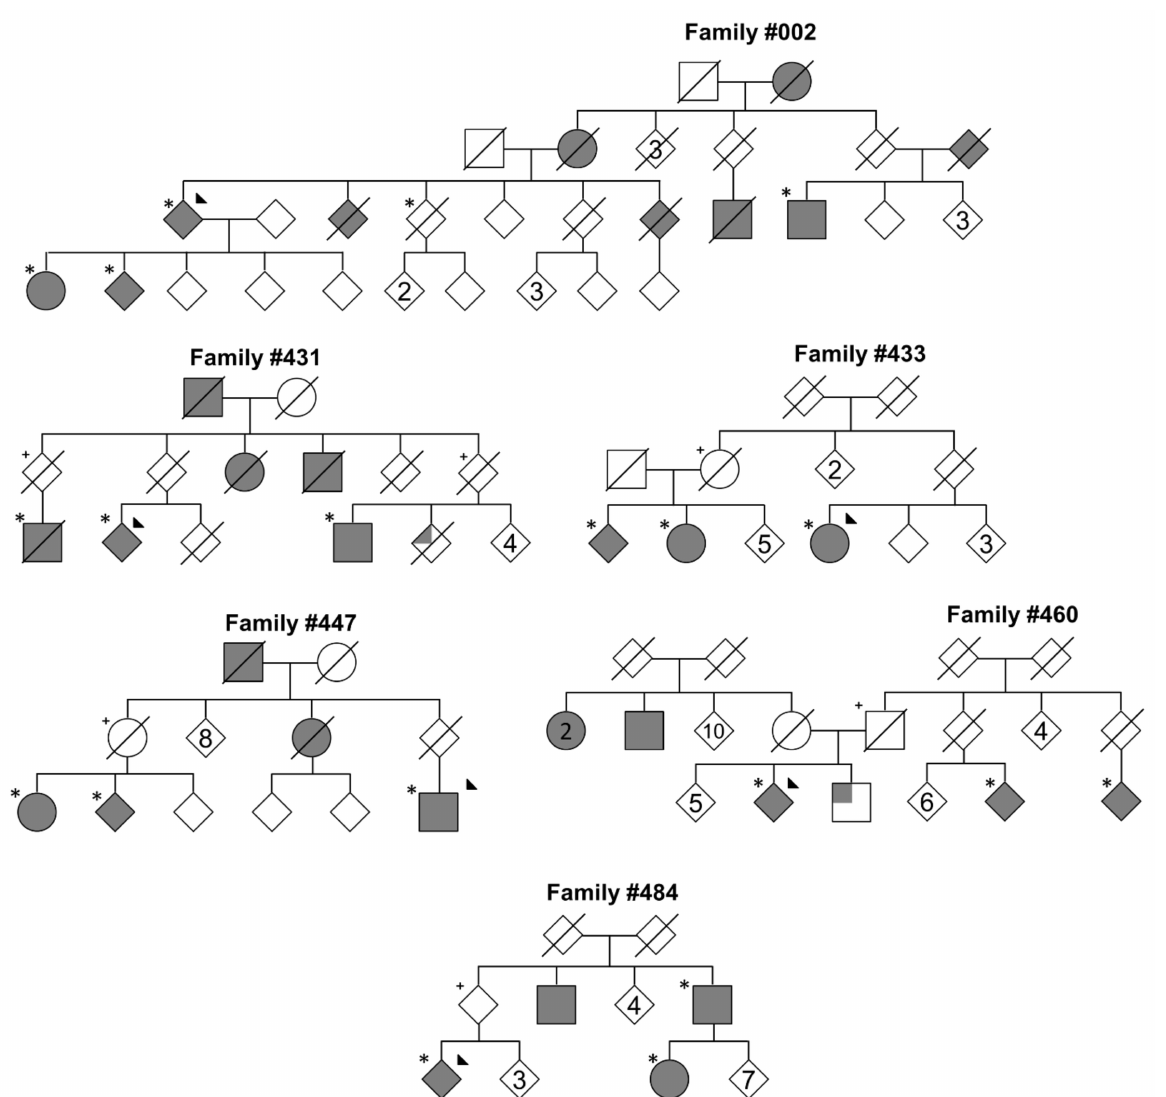
Figure 1. Six multi-incident families from the Queensland Parkinson’s Project. Full shaded shapes represent Parkinson’s disease (PD). Upper shaded quadrants represent an undiagnosed tremor. Those with a star indicate Whole Exome Sequencing (WES) sequencing. Figures depicted with plus sign represent individuals that were both >80 years of age and inferred carrier of variants. Triangle suggests proband case. Gender disclosed and minimum data shown to protect the privacy of the